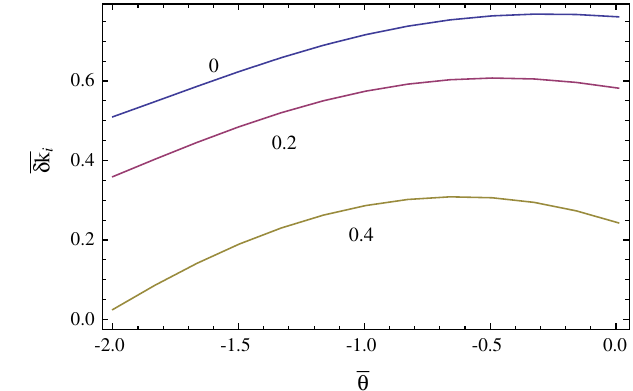
FIG. 2. Detuning curves of the fundamental (0, 0) mode for ¼ 0 , 0.5, 1, and 1.5 with (cid:1) (cid:2) (cid:5) d